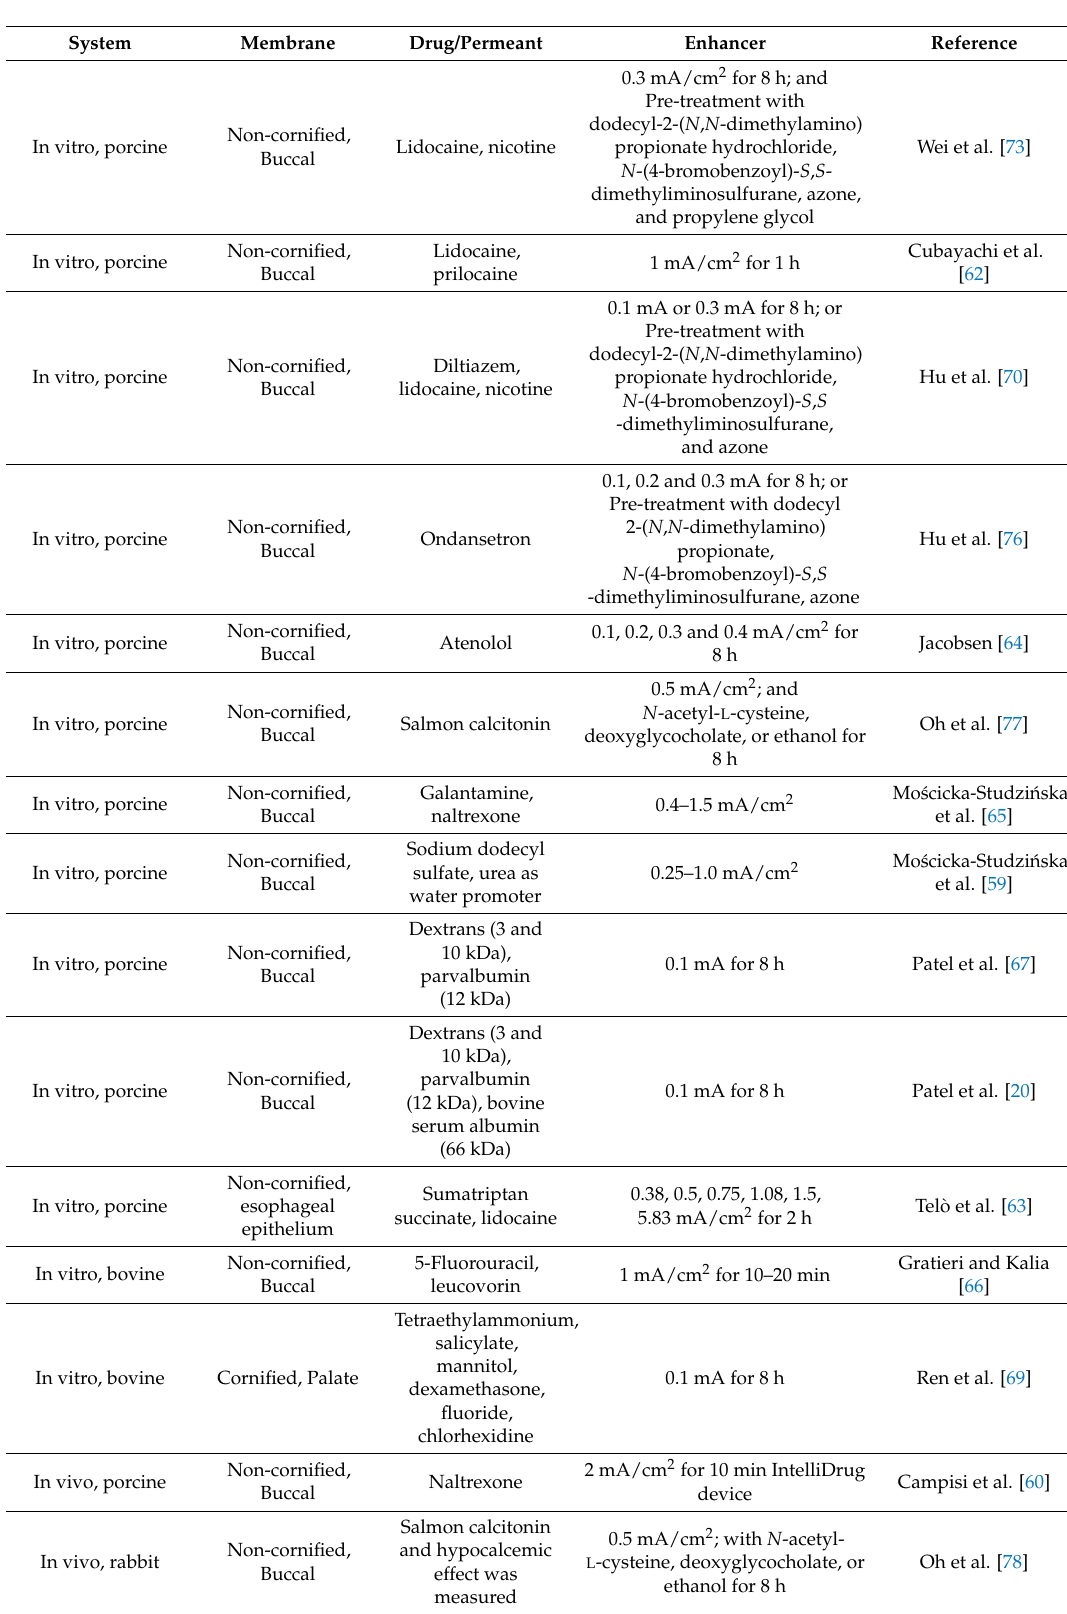
Table 2. Summary of studies on iontophoresis in soft tissue in the oral cavity.